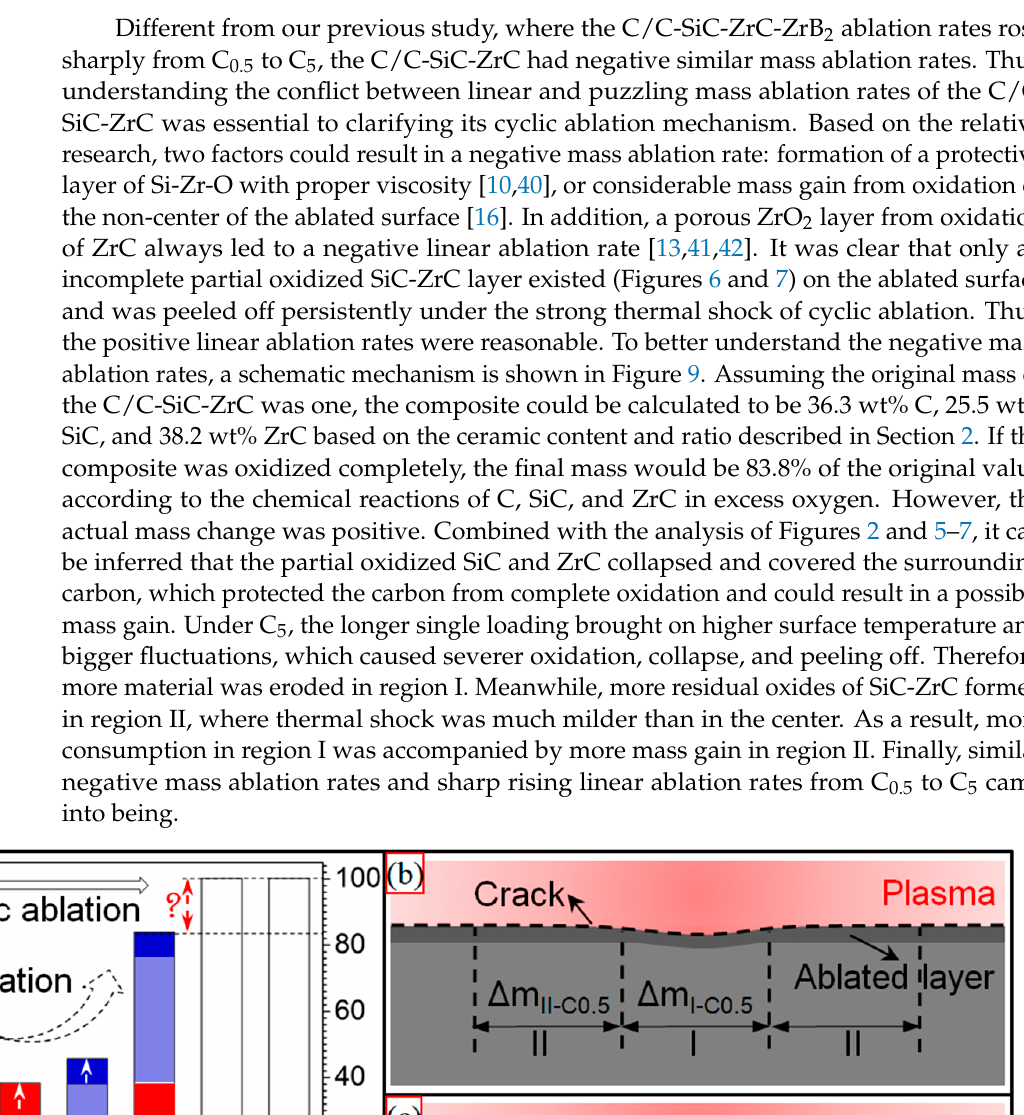
7 of 9 Figure 8. Surface temperatures of the C/C-SiC-ZrC samples during ablation. 3.2. Ablation Mechanism Different from our previous study, where the C/C-SiC-ZrC-ZrB 2 ablation rates rose